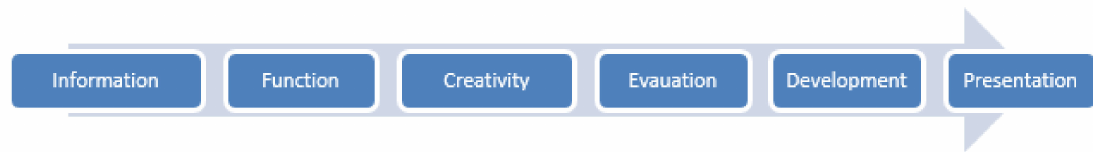
Figure 3. Phases to adopt the value management (VM)